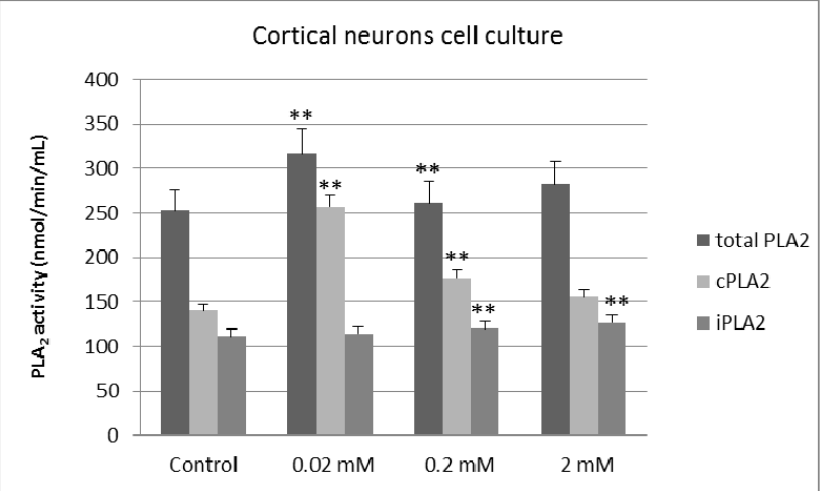
Figure 2. Effects of different concentrations of lithium chloride on the activities of total PLA 2 , cPLA 2 and iPLA 2 in cultured cortical neurons ( n = 5, ** p < 0.02).